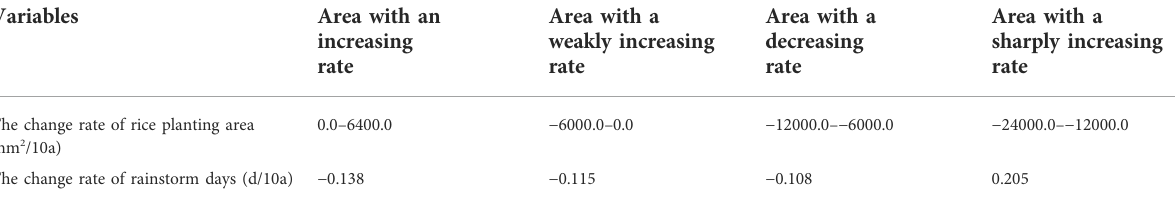
TABLE 6 The change rate of rice planting area corresponding with the rainstorm events.